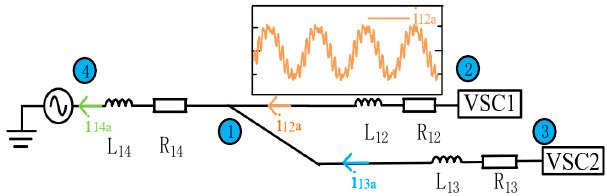
Figure 11. Example space diagram and resonant branch waveform.